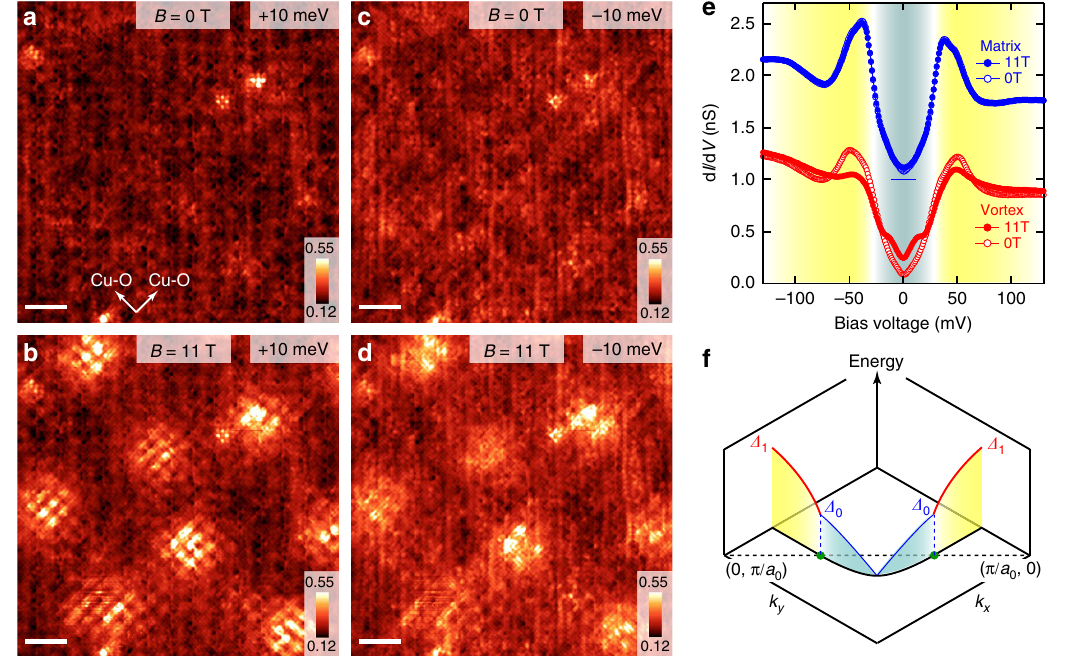
Figure 1 | Spectroscopic features of vortices and nodal–antinodal dichotomy. ( a , b ) Differential conductance maps at energy E ¼ þ 10meV in magnetic fields B ¼ 0 and 11T, respectively. White arrows in a denote the Cu–O bonding directions. Vortices and their internal structures (vortex checkerboard) are clearly imaged in b . ( c , d ) Differential conductance maps at E ¼ (cid:3) 10meV taken in B ¼ 0 and 11T. Scale bars, 50Å ( a – d ), and the colour scales are in nano siemens (nS). The tunnelling conductance at each location was obtained by numerical differentiation of the current–voltage characteristics and by post- smoothing with the energy window of ± 2meV. ( e ) Comparison between tunnelling spectra taken at B ¼ 0T (open symbols) and 11T (solid symbols). Red and blue data depict the spectra spatially averaged over the regions near vortices and far from vortices, respectively. ( f ) Schematic illustration of the excitation gap in momentum-space showing the dichotomy between the d -wave superconductivity near the node (light blue area) and the antinodal states governed by the pseudogap (yellow area). These two regimes are separated by the line connecting ( p / a 0 , 0) and (0, p / a 0 ), where a 0 denotes Cu–O–Cu distance 1,2